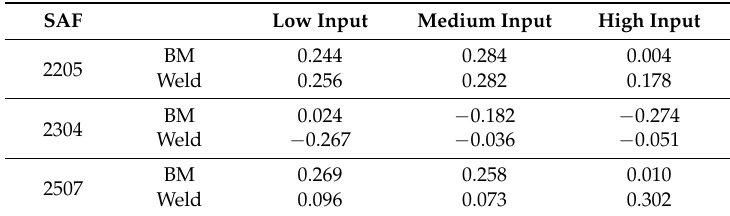
Table 4. E cor r (V) for DSS and SDSS (wt